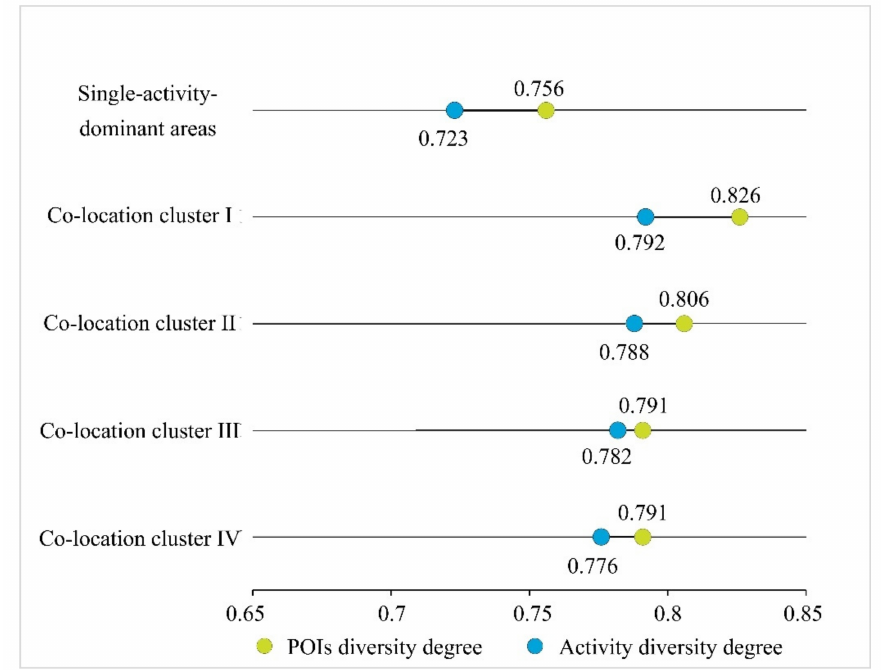
Figure 9. The diversity degrees of POIs and resident activity within different